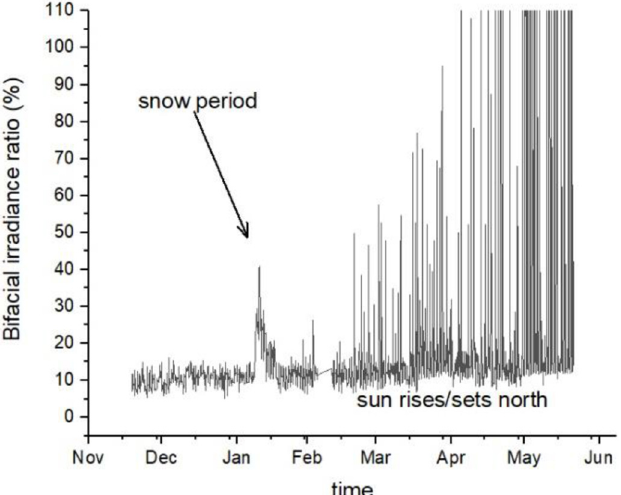
Fig. 8. Bifacial irradiance ratio at our location over the reported time period. The period in which it snowed is easily found in the irradiance data (indicated by arrows). Starting at the astronom- ical spring, the bifacial irradiance increases at sunrise and sunset. The maximum bifacial irradiance ratio can reach up to 500 % for clear weather when nearing the onset of summer.